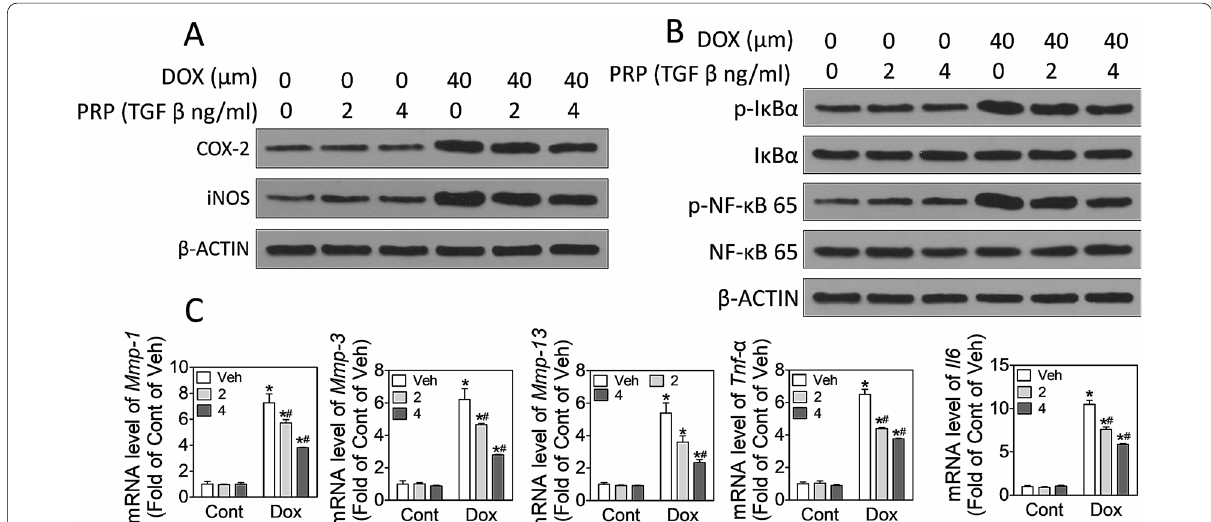
Fig. 5 PRP inhibits doxorubicin-induced inflammation in SW1353. SW1353 were treated with PRP and doxorubicin for 24 h. A , B Western blot to detect protein levels of COX-2, iNOS, p-IκBα, IκBα, p-NF-κB 65, NF-κB 65, and β-actin. C mRNA levels of MMP-1, MMP-3, MMP-13, TNF-α, and IL-6. At least three independent experiments were performed. * p < 0.05 vs control of the same doxorubicin treatment; # p < 0.05 vs vehicle of the same TGFβ